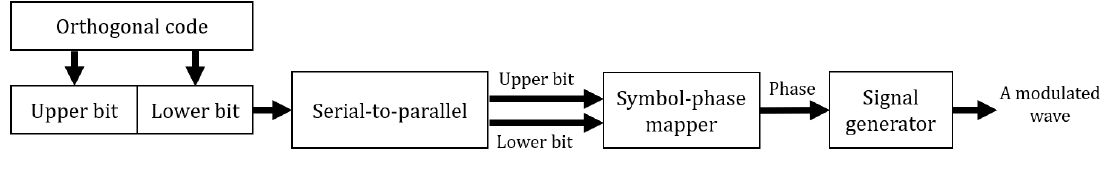
Figure 8. Generation process of the modulated ID.